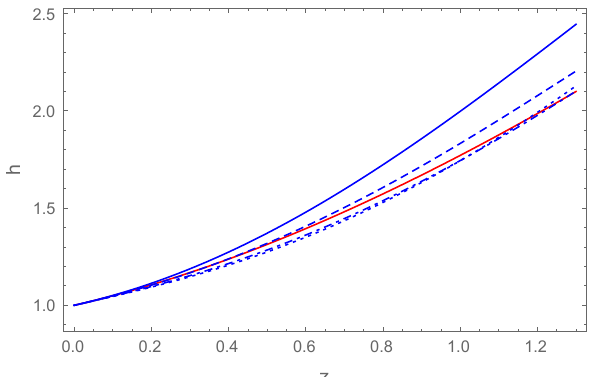
(cid:0) (cid:1) β 2 R µν + β 3 T µν with